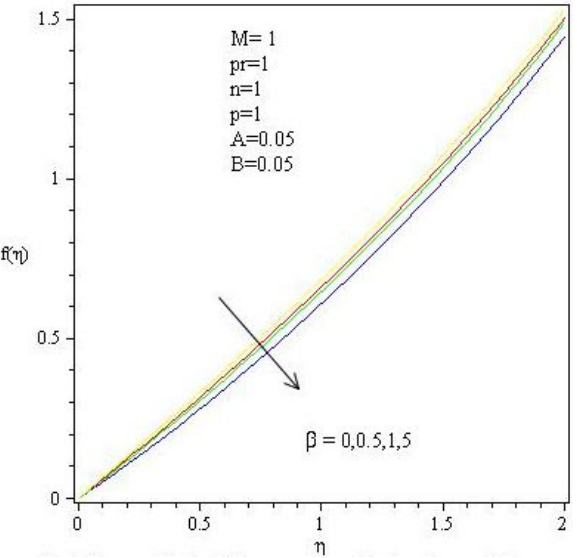
Fig. 3: Flow profile for different values of β when λ = σ =